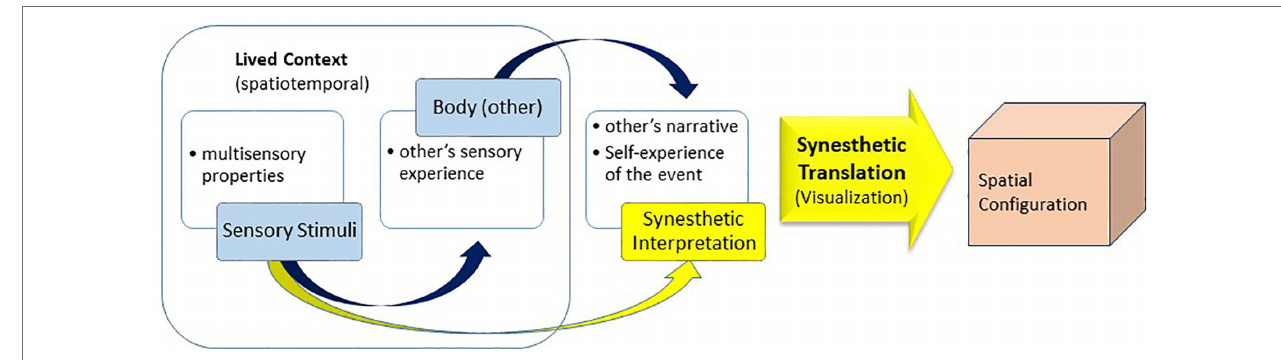
FIGURE 5 | Synesthetic translation model for design